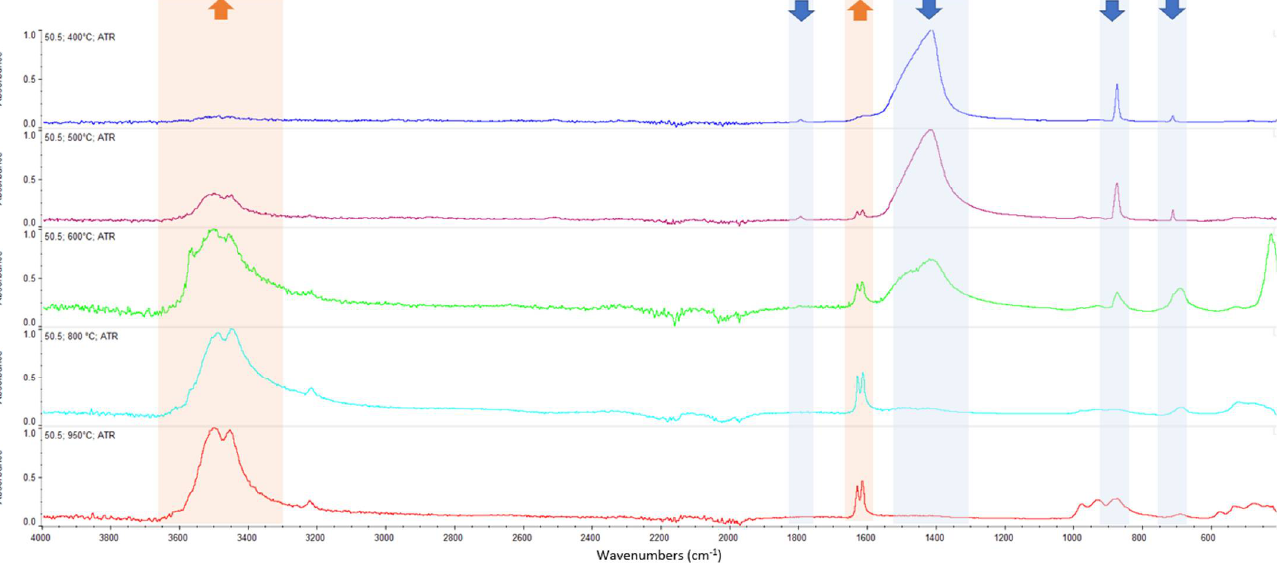
Figure A6. FTIR spectra of ashes of F50.5 at 950 °C (red), at 800 °C (light blue), at 600 °C (green), at 500 °C (purple), at 400 °C (blue).